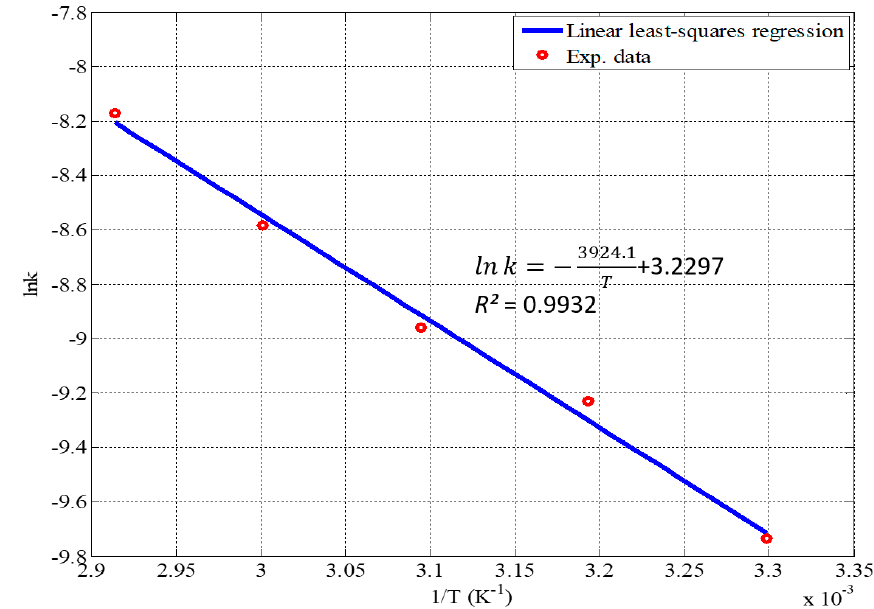
Figure 5. Linear least-squares regression for calculating kinetic parameters.